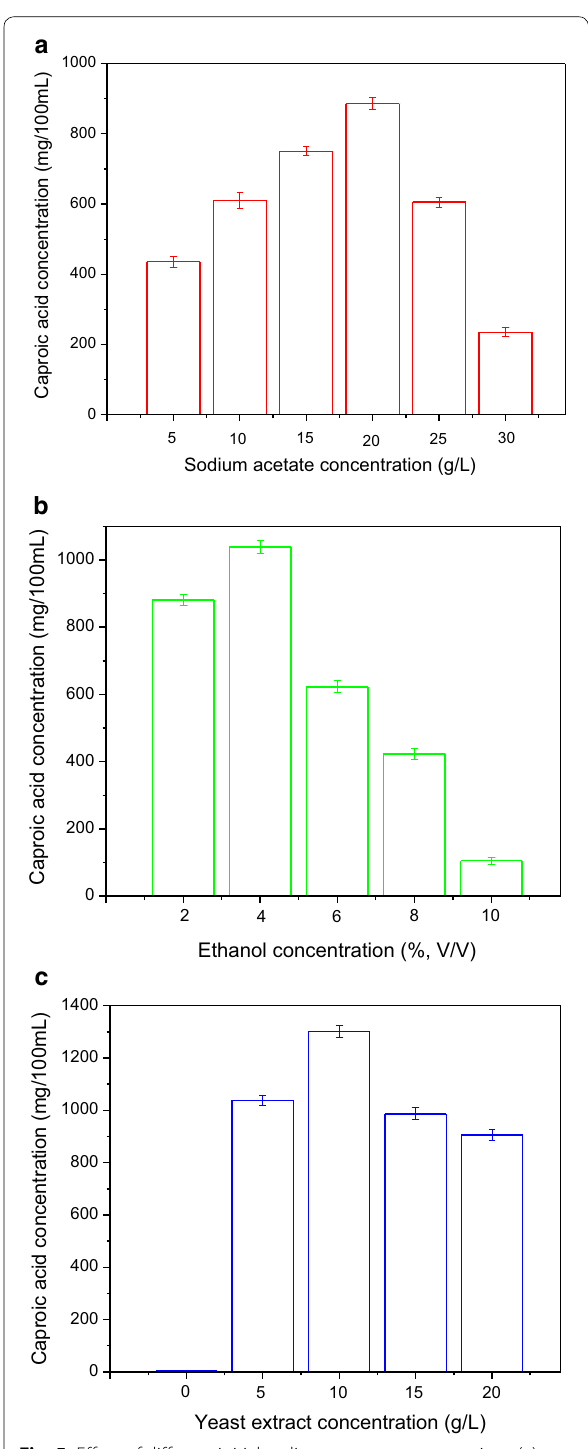
Fig. 5 Effect of different initial sodium acetate concentrations ( a ), ethanol concentrations ( b ), and yeast extract concentrations ( c ) on caproic acid production by the co-culture fermentation of C. kluyveri H588 and Methanogen